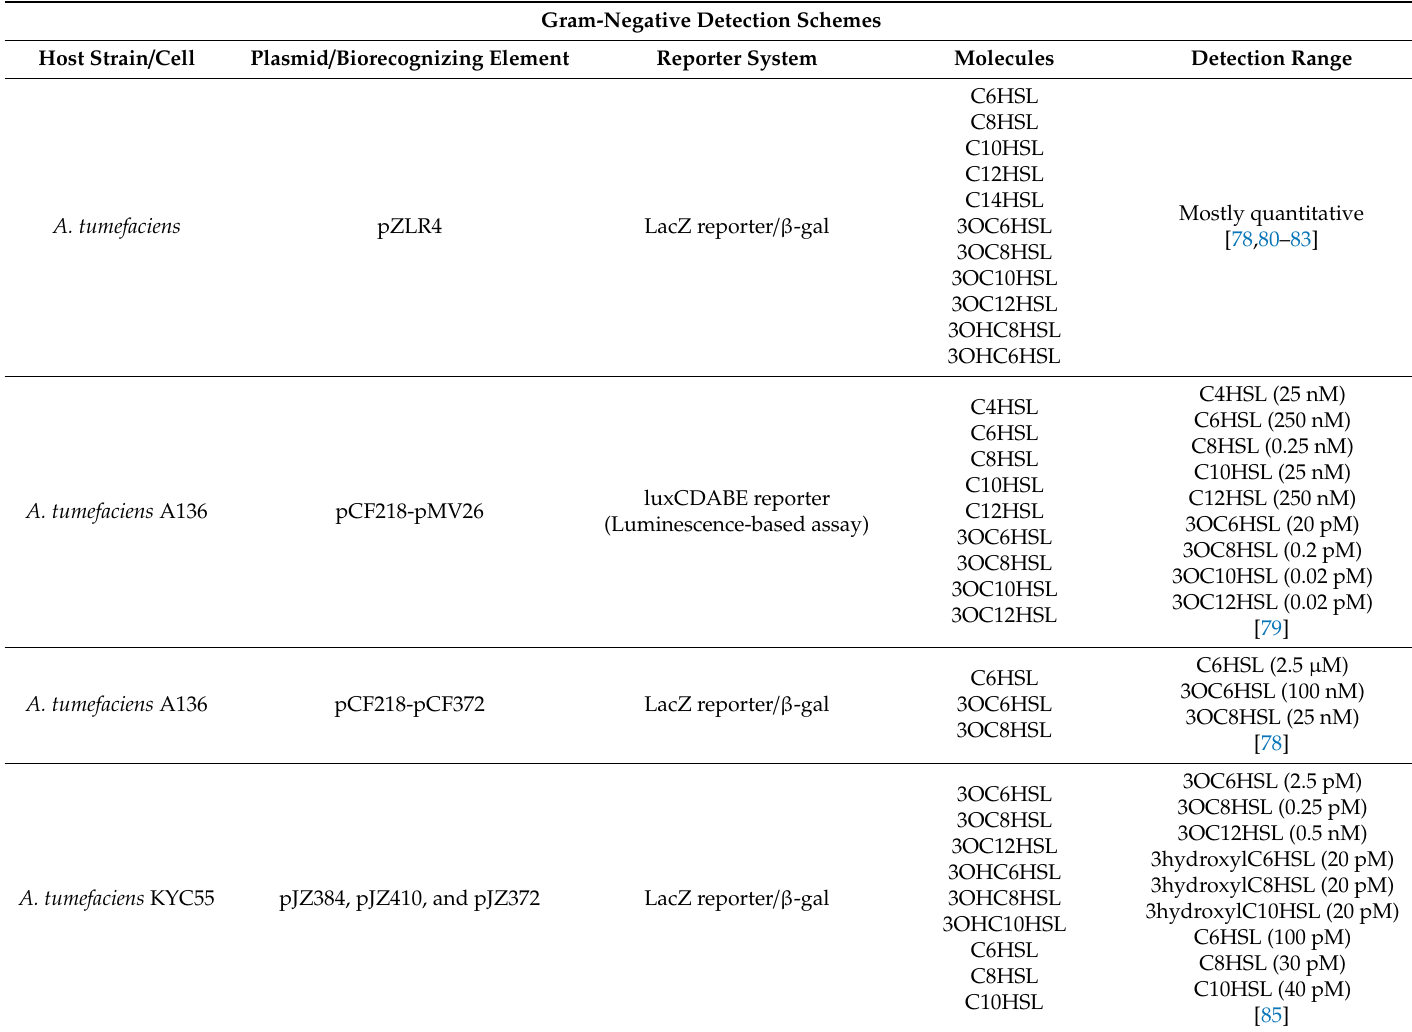
Table 3. Gram-negative detection